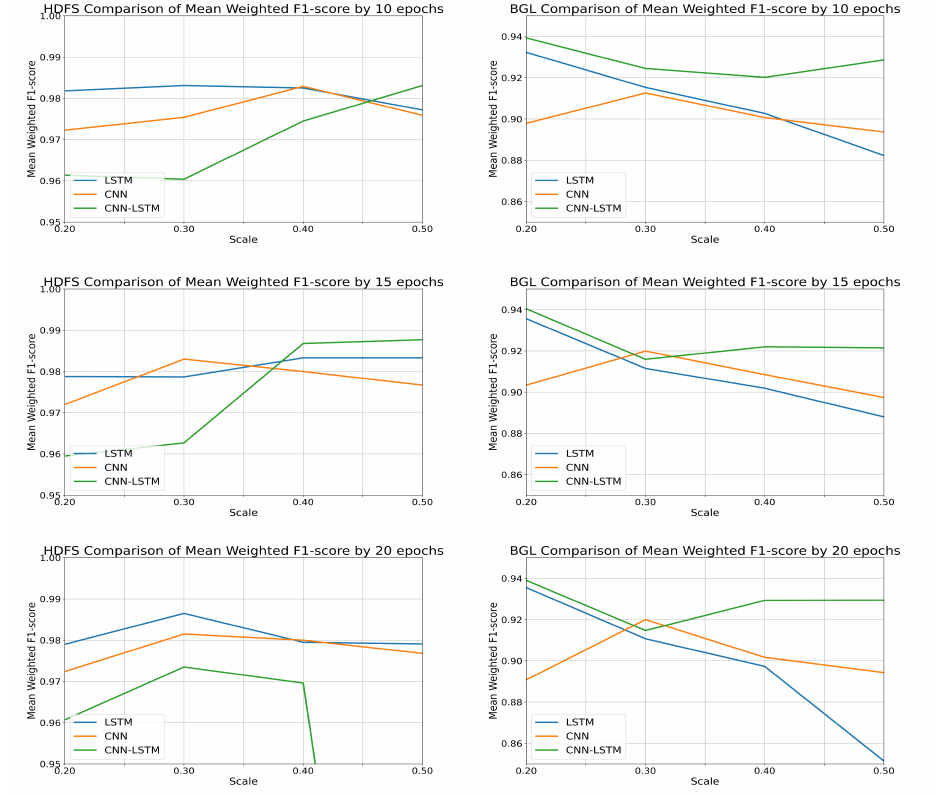
Figure 6. Weighted F1-Score comparison results by